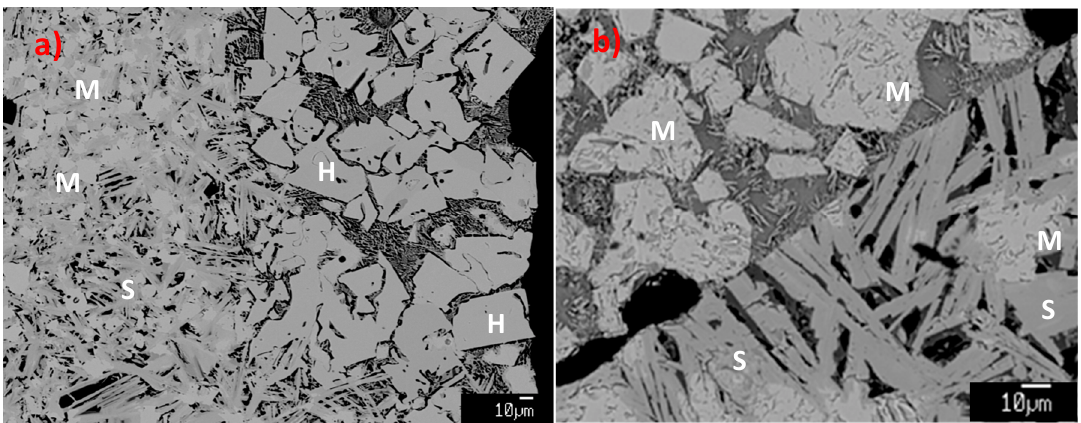
Figure 14. Examples of the heterogeneous structure of the sinter materials, ( a ) hematite present close to the pore or surface, and ( b ) interface between regions containing (SFCAM + magnetite + liquid) and (magnetite + liquid) (S—SFCA, M—Magnetite, H—Hematite) (BSE images).